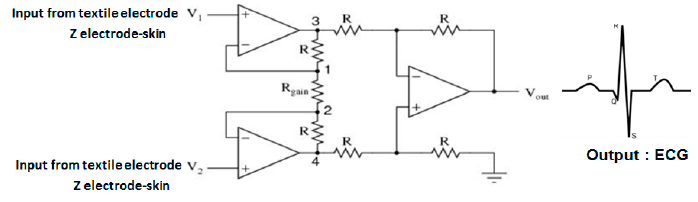
Figure 25. General circuit for ECG acquiring.